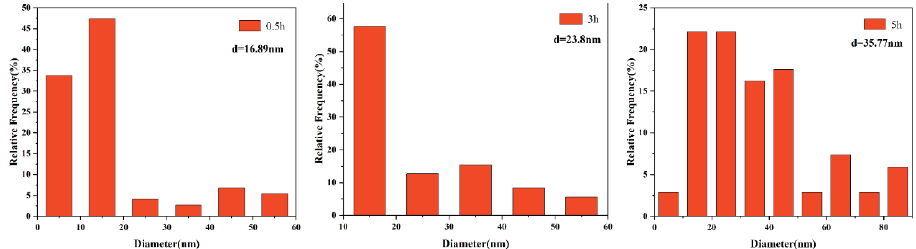
Figure 6. The distribution of NbC precipitates size after different holding time at the austenitizing temperature of 950 °C.